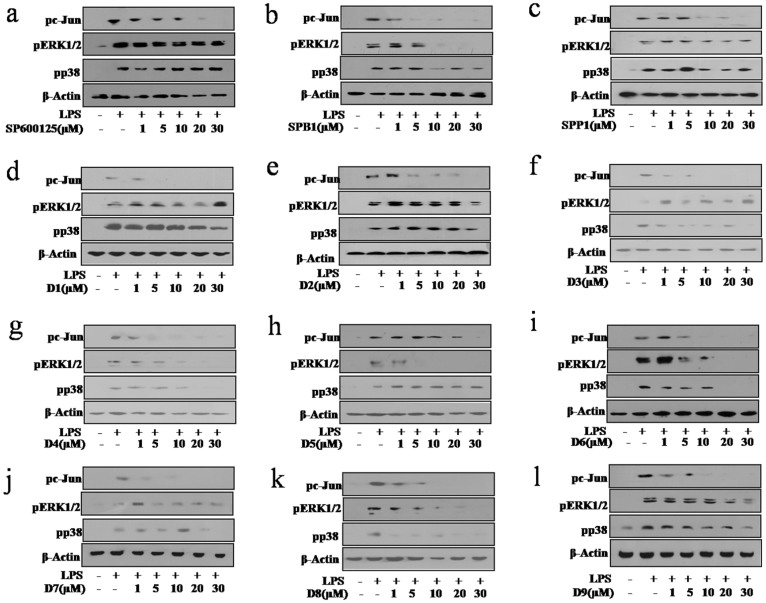
Treatment of mouse macrophages with anthrapyrazolone and its analogues reduces activation of MAPkinase along with JNK to a varied extent.Western blot analysis of pc-Jun in macrophages treated with respective inhibitors at higher concentrations as shown in (a) SPB1, (b) SPP1, (c) D9, (d) D1 (2-hydroxyethyl), (e) D2, (2-hydroxyethyl-7-chloro), (f) D3, (g) D4, (h) D5, (i) D6, (j) D7, (k) D8 and (l) SP600125 for 1 hour followed by LPS (100 ng/ml) treatment for additional 1 hour. Representative blots of three independent experiments are shown.